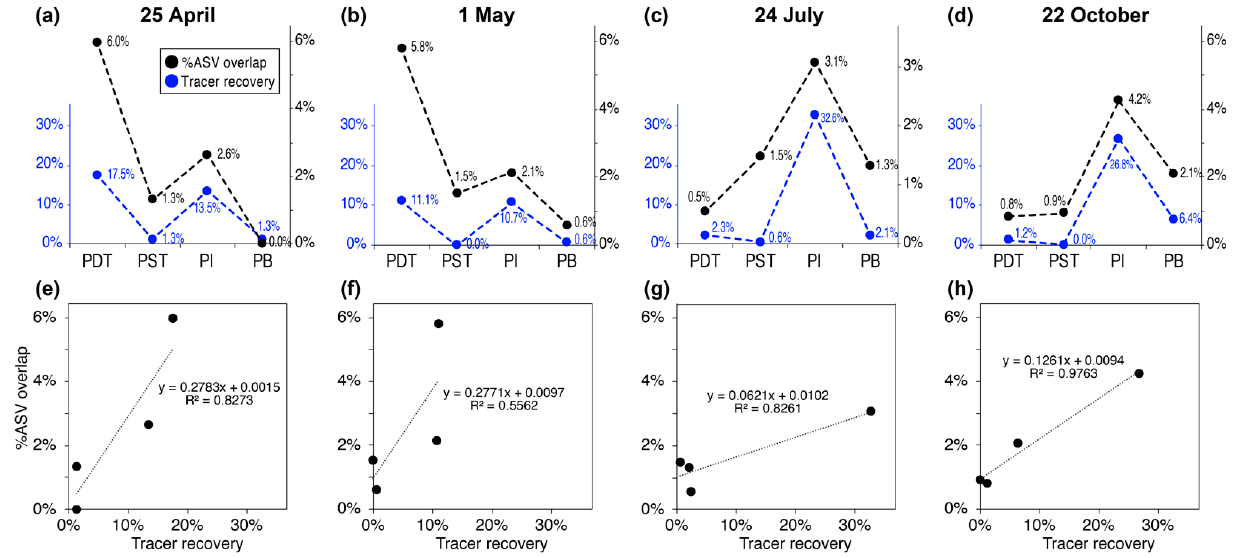
Figure 8. Trends in %ASV overlap and tracer recovery values across producing wells near the tracer campaign on 25 April ( a , e ), 1 May ( b , f ), 24 July ( c , g ), and 22 October ( d , h ). ( a – d ) highlight the consistent trends of the two types of data across wells. ( e – h ) cross-plot the %ASV overlap values ( y -axis) and the tracer recovery values ( x -axis) in each time period, showing a positive correlation in all cases.